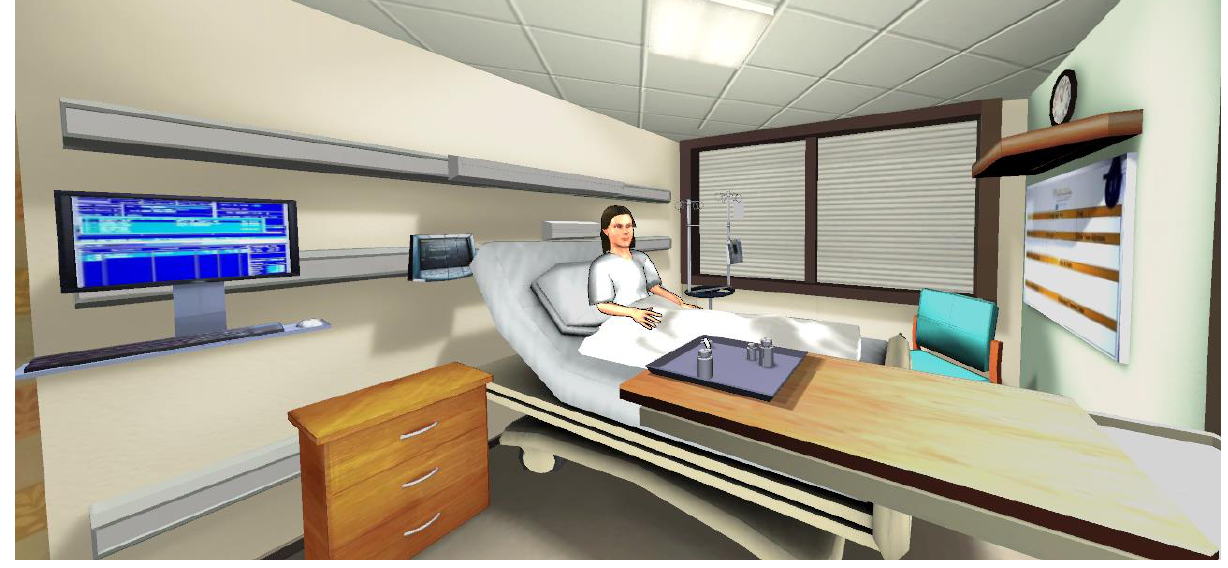
Figure 1. Example of a 3D virtual environment streamed via the Internet directly onto the learner’s computer (ie, Web-based) where the user can freely walk around and interact with the environment—authors’project in collaboration with Clemson University, SC,